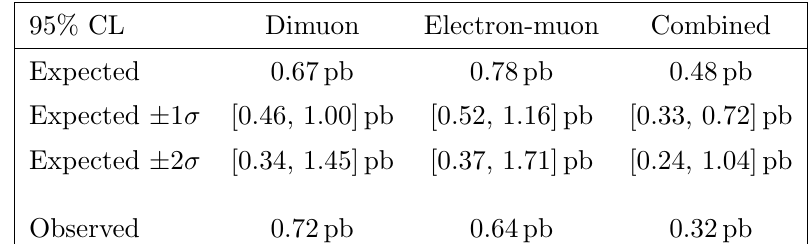
Table 3 . Expected and observed 95% CL limits on the cross section for inclusive same-sign WW production via DPS for the dimuon and electron-muon channels along with their combination.